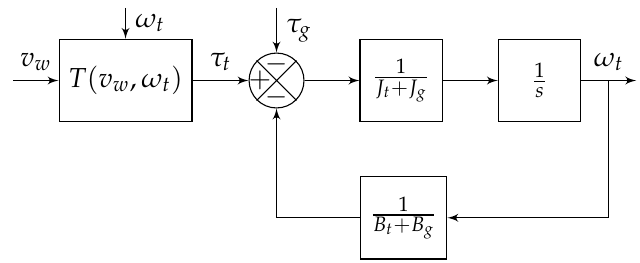
Figure 7. Matlab/Simulink diagram modeling the turbine dynamics.